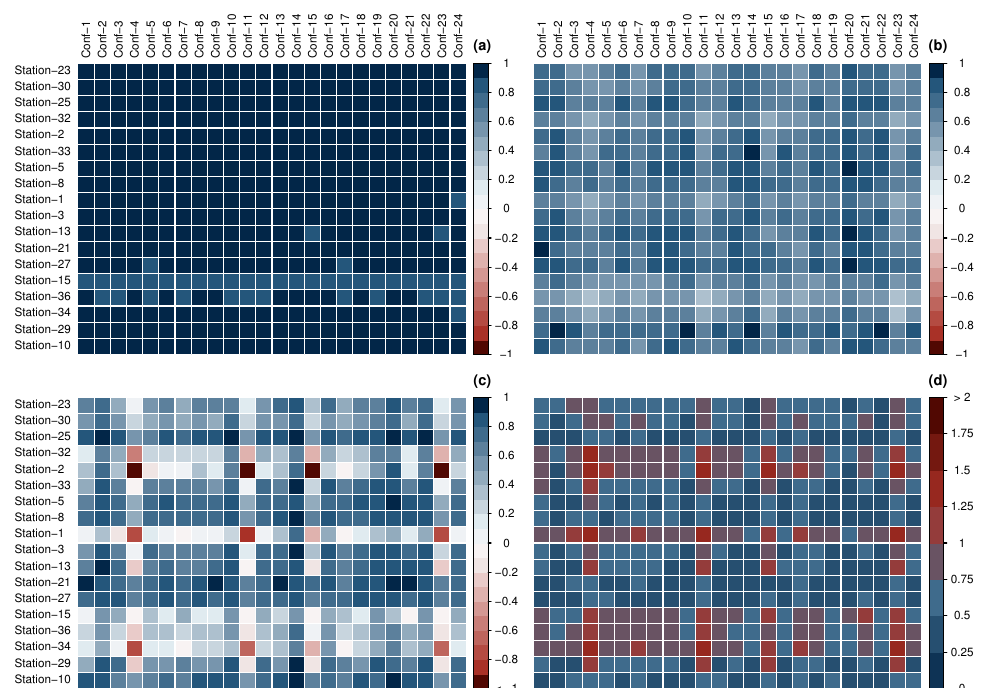
Figure A1. Matrix of statistics for maximum temperature: ( a ) correlation, ( b ) KGE, ( c ) NSE, ( d )